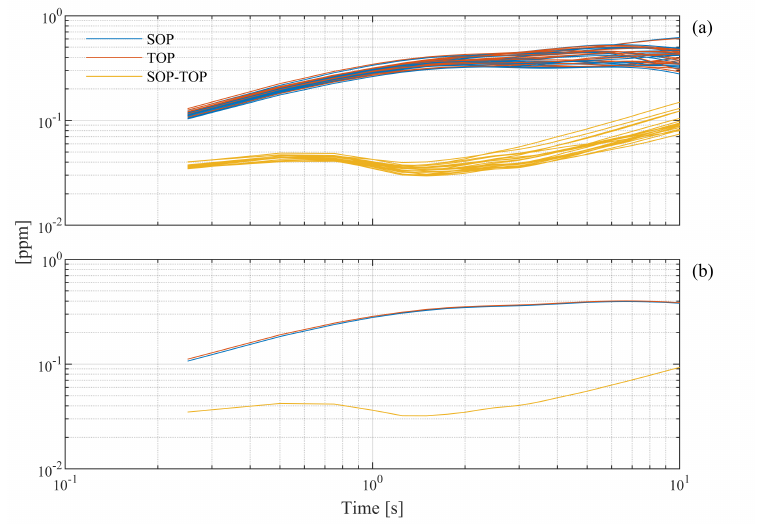
Figure 9. ( a ) The Allan deviation (as a function of averaging time) for the SOT refractometer (blue curves), the TOP refractometer(red curves), and their difference (yellow curves) assessed over 20 cycles. ( b ) The average of each set of data in panel ( a